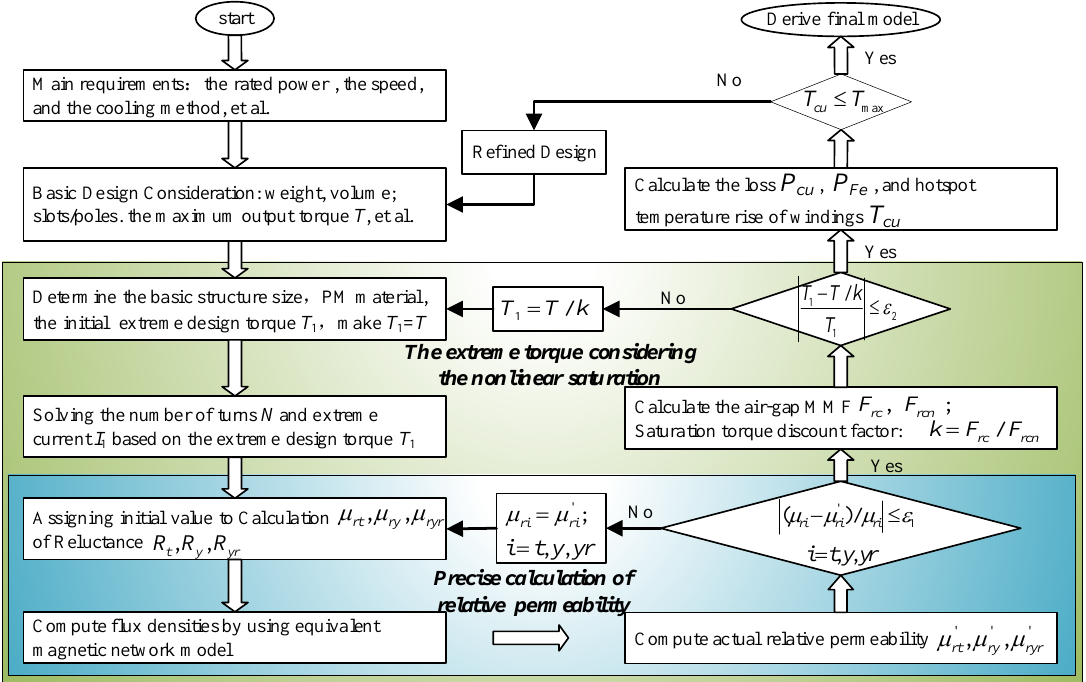
Figure 7. The design procedure of STHO-PMSM considering the iron core nonlinear saturation.